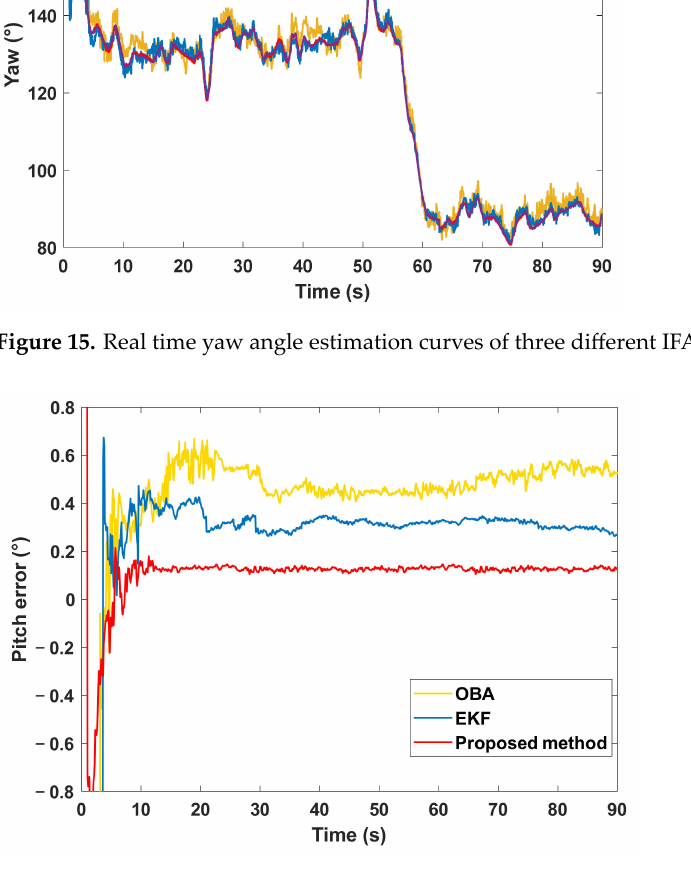
Figure 16. Pitch angle alignment errors of three different IFA